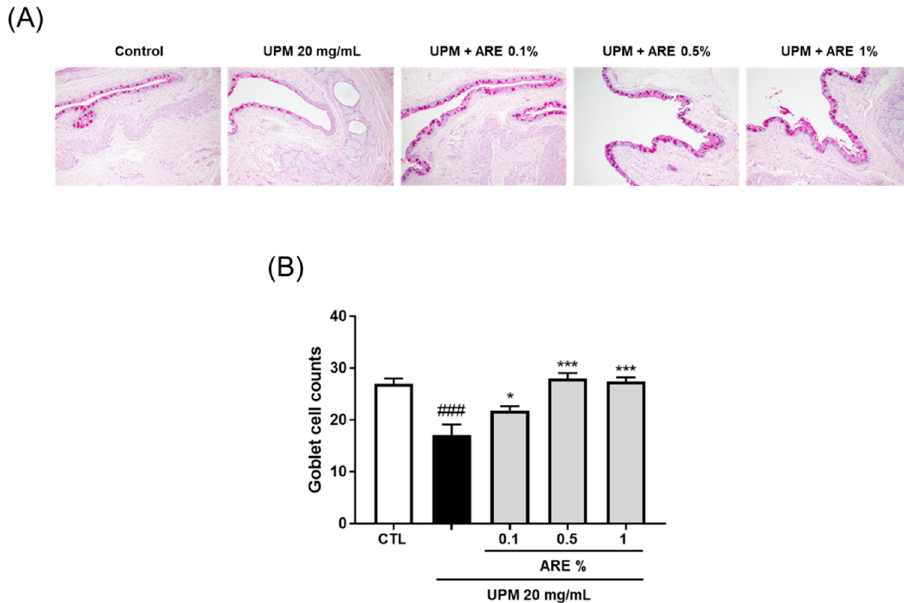
Figure 5. Achyranthis radix extract restored rMuc4 expression in the corneal epithelium. ( A ) Immunohistochemical staining of the corneal epithelium was performed by immunostaining the paraffin-embedded corneal sections for rMuc4. The immunostained sections were counterstained with hematoxylin. ( B ) Each bar represents mean rMuc4 fluorescence signal intensity ± SEM, n ≥ 5. ### p < 0.001 vs. control group, * p < 0.05 vs. UPM group. ARE, Achyranthis radix extract; UPM, urban particulate matter; CTL, control; AU, arbitrary units; SEM, standard error of mean.